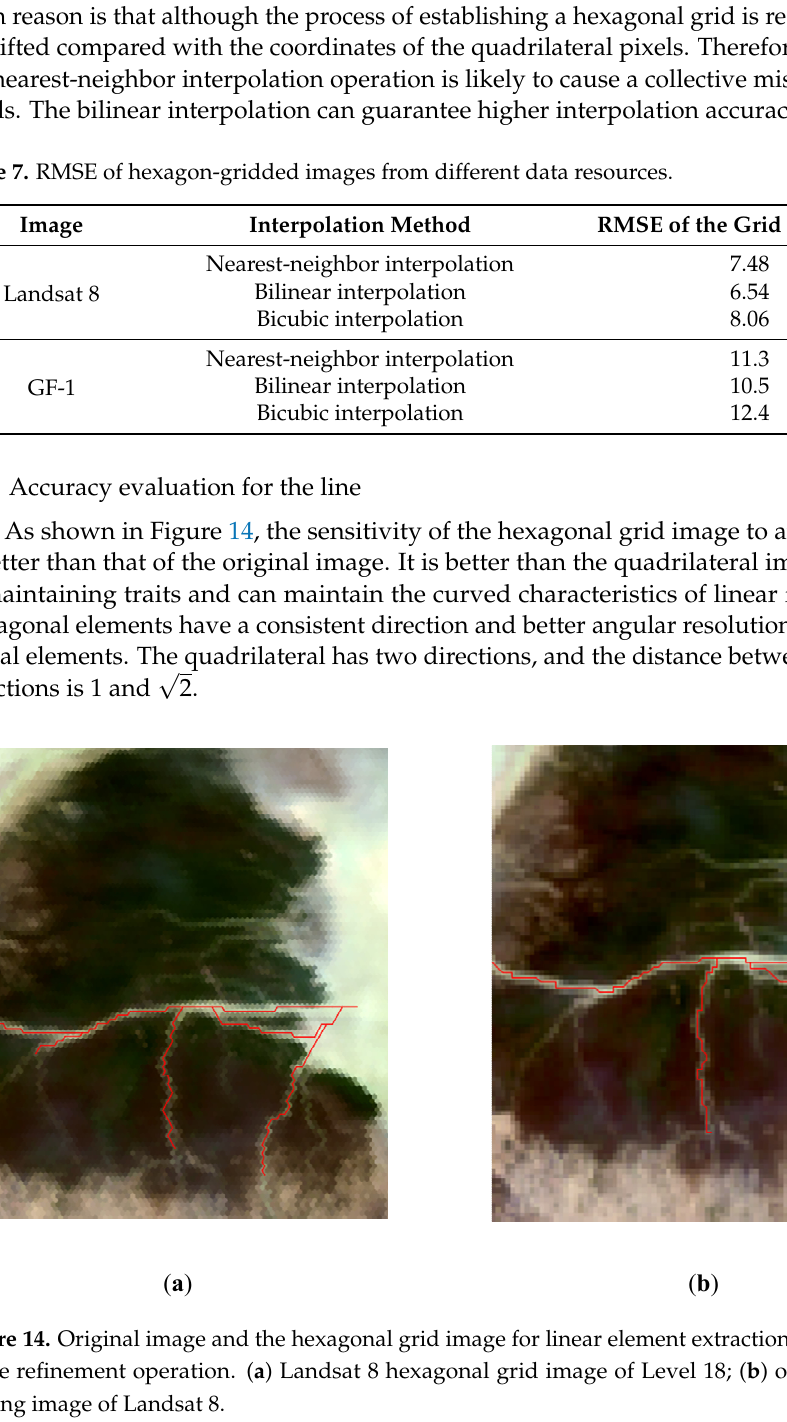
Figure 15. Comparison of linear feature extraction results among the original Landsat 8 hexagonal image and vector data. Table 8. Error band of different data resources. Vector Data